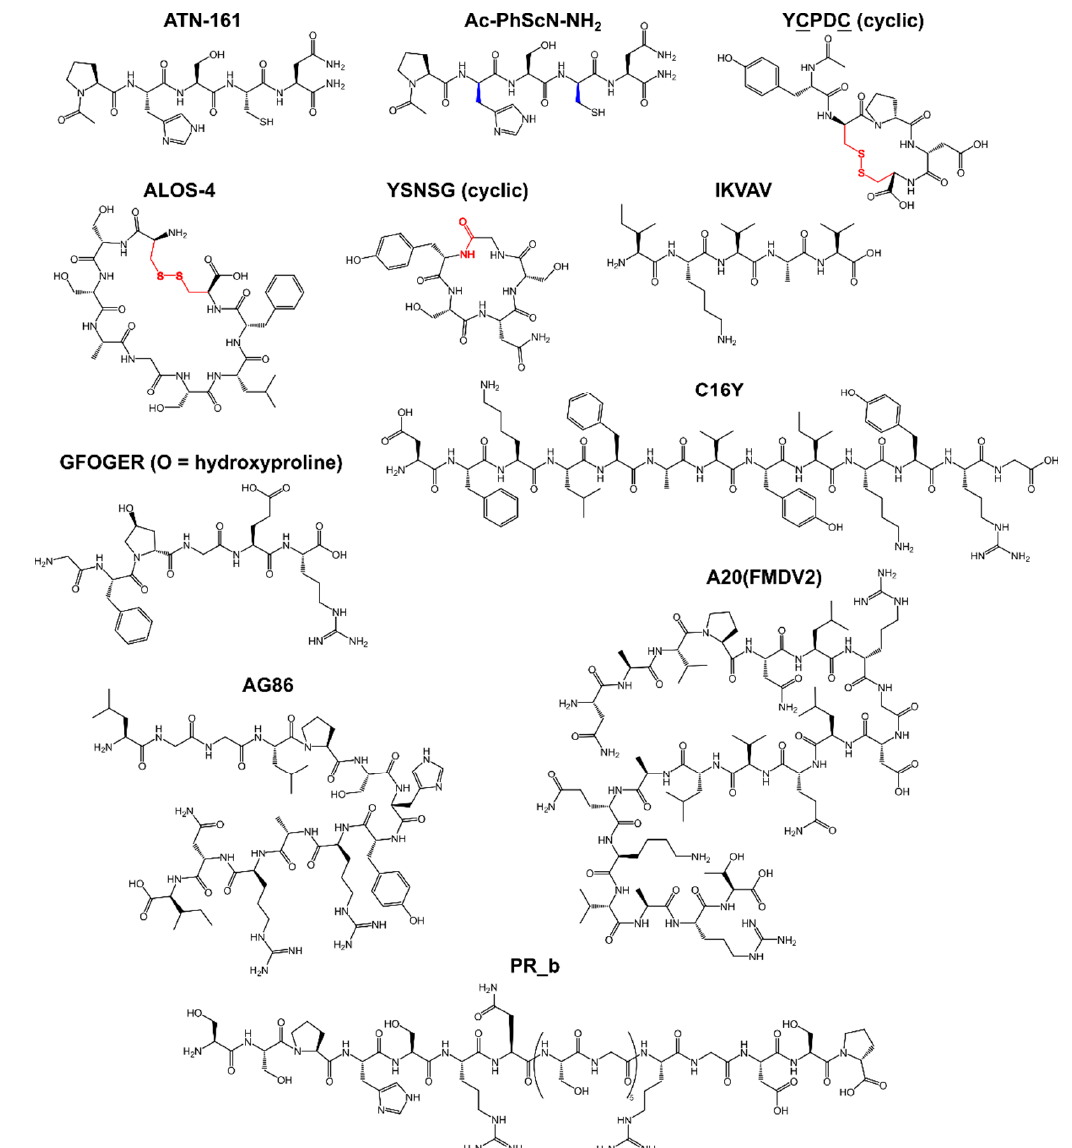
Scheme 4. Chemical structures of non-RGD based integrin-binding peptides. Color code: the original nal peptide sequence of the predecessor peptide is indicated in black; D -residues are indicated in peptide sequence of the predecessor peptide is indicated in black; D-residues are indicated in blue; blue; and conjugation groups for cyclic peptides are indicated in red. O—hydroxyproline. and conjugation groups for cyclic peptides are indicated in red.